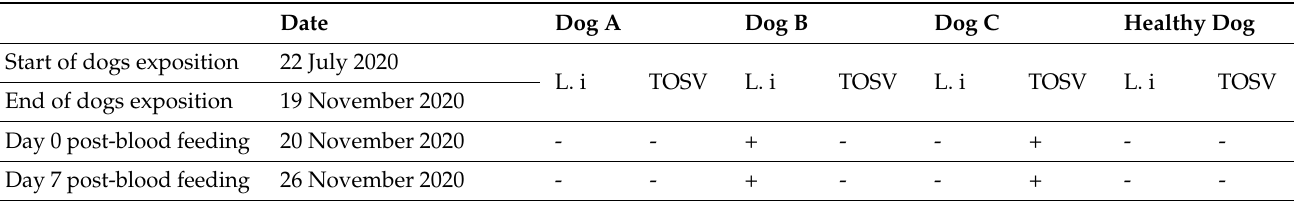
Table 3. Detection of L. infantum and TOSV in P. perniciosus fed on